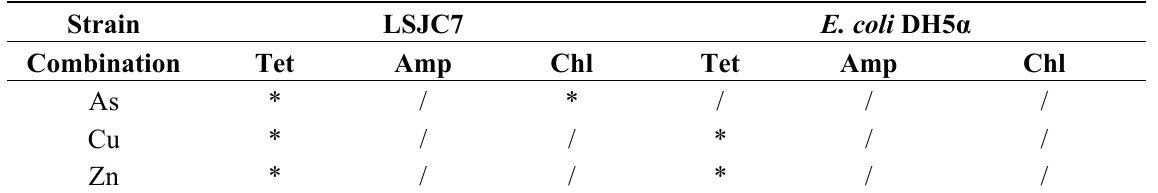
Table 1. Summery of heavy metal mediated antibiotic resistance in LSJC7 and Escherichia coli DH5 α .